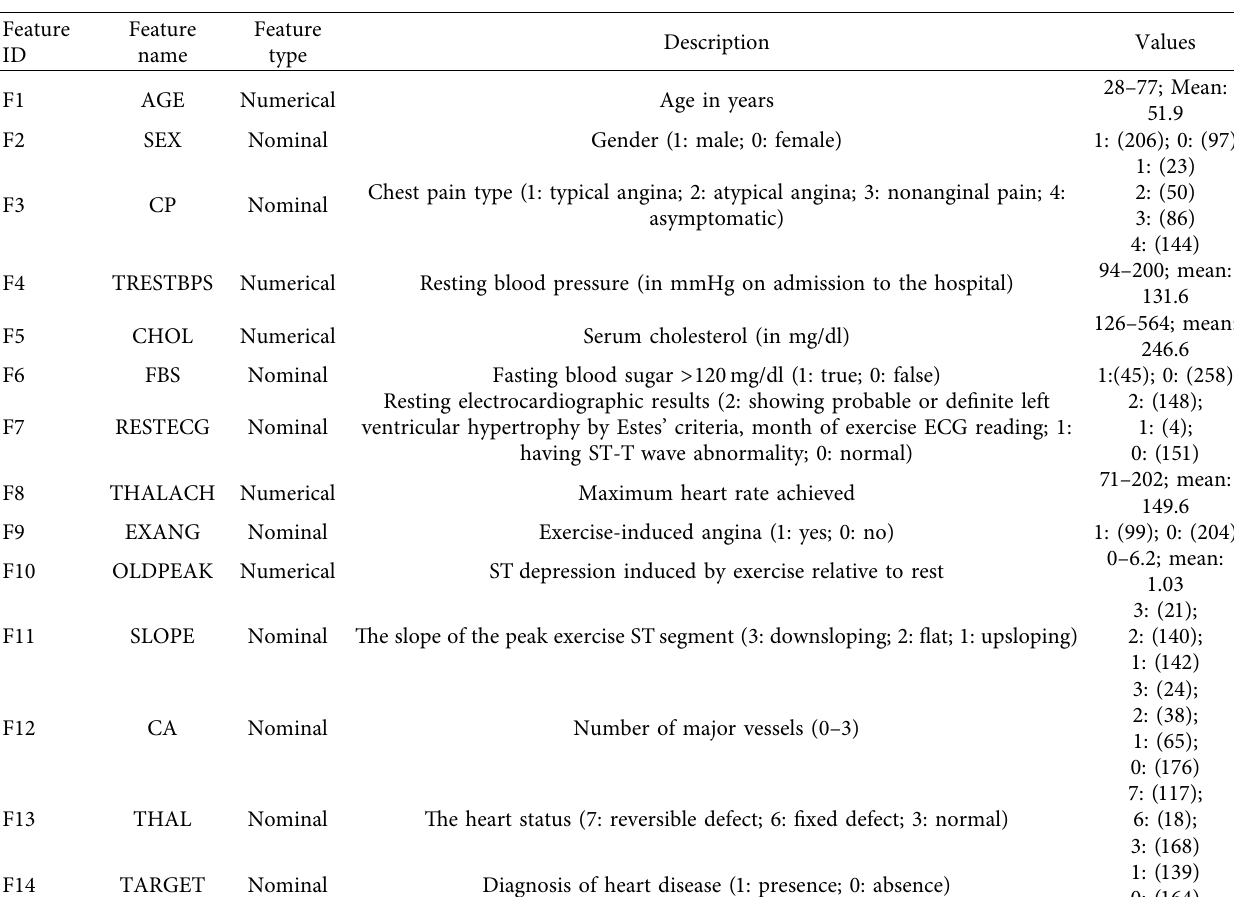
Table 1: Description of Cleveland heart disease